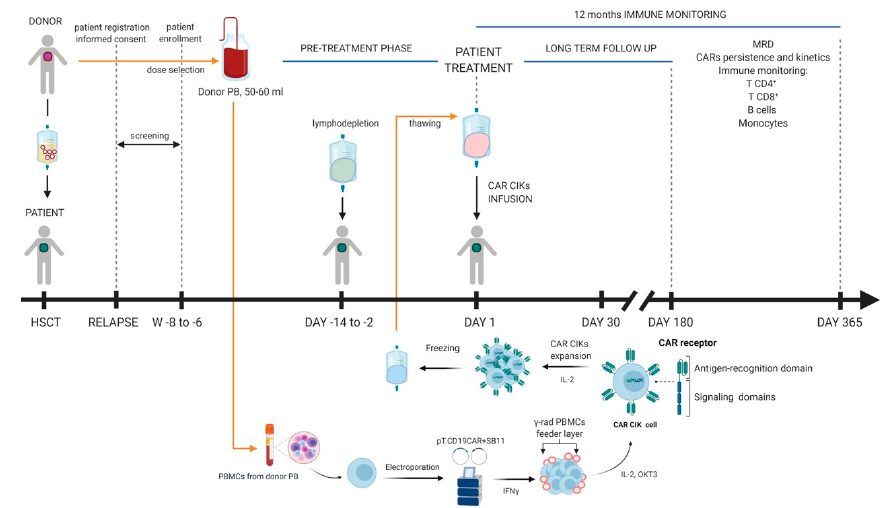
Figure 3. Overview of donor-derived SB-engineered CARCIK-CD19 therapy; 50–60mL of donor PB are collected and PBMCs are isolated and nucleofected at day 0 with SB vectors. Gamma-irradiated PBMCs are added as feeder together with IFN- γ ; at day 1 cells are stimulated with IL-2 and OKT3 and CARCIK-CD19 cells are expanded in vitro and frozen on days 18–21; during the pre-treatment phase (days 2 to 14) the patient undergoes lymphodepletion and then, on day 1 of the treatment phase, CARCIK-CD19 are thawed and subsequently infused into the patient; after the infusion, the patient is subjected to a long-term follow-up until the fifth year and to 12 months immune monitoring. Created with Biorender.com